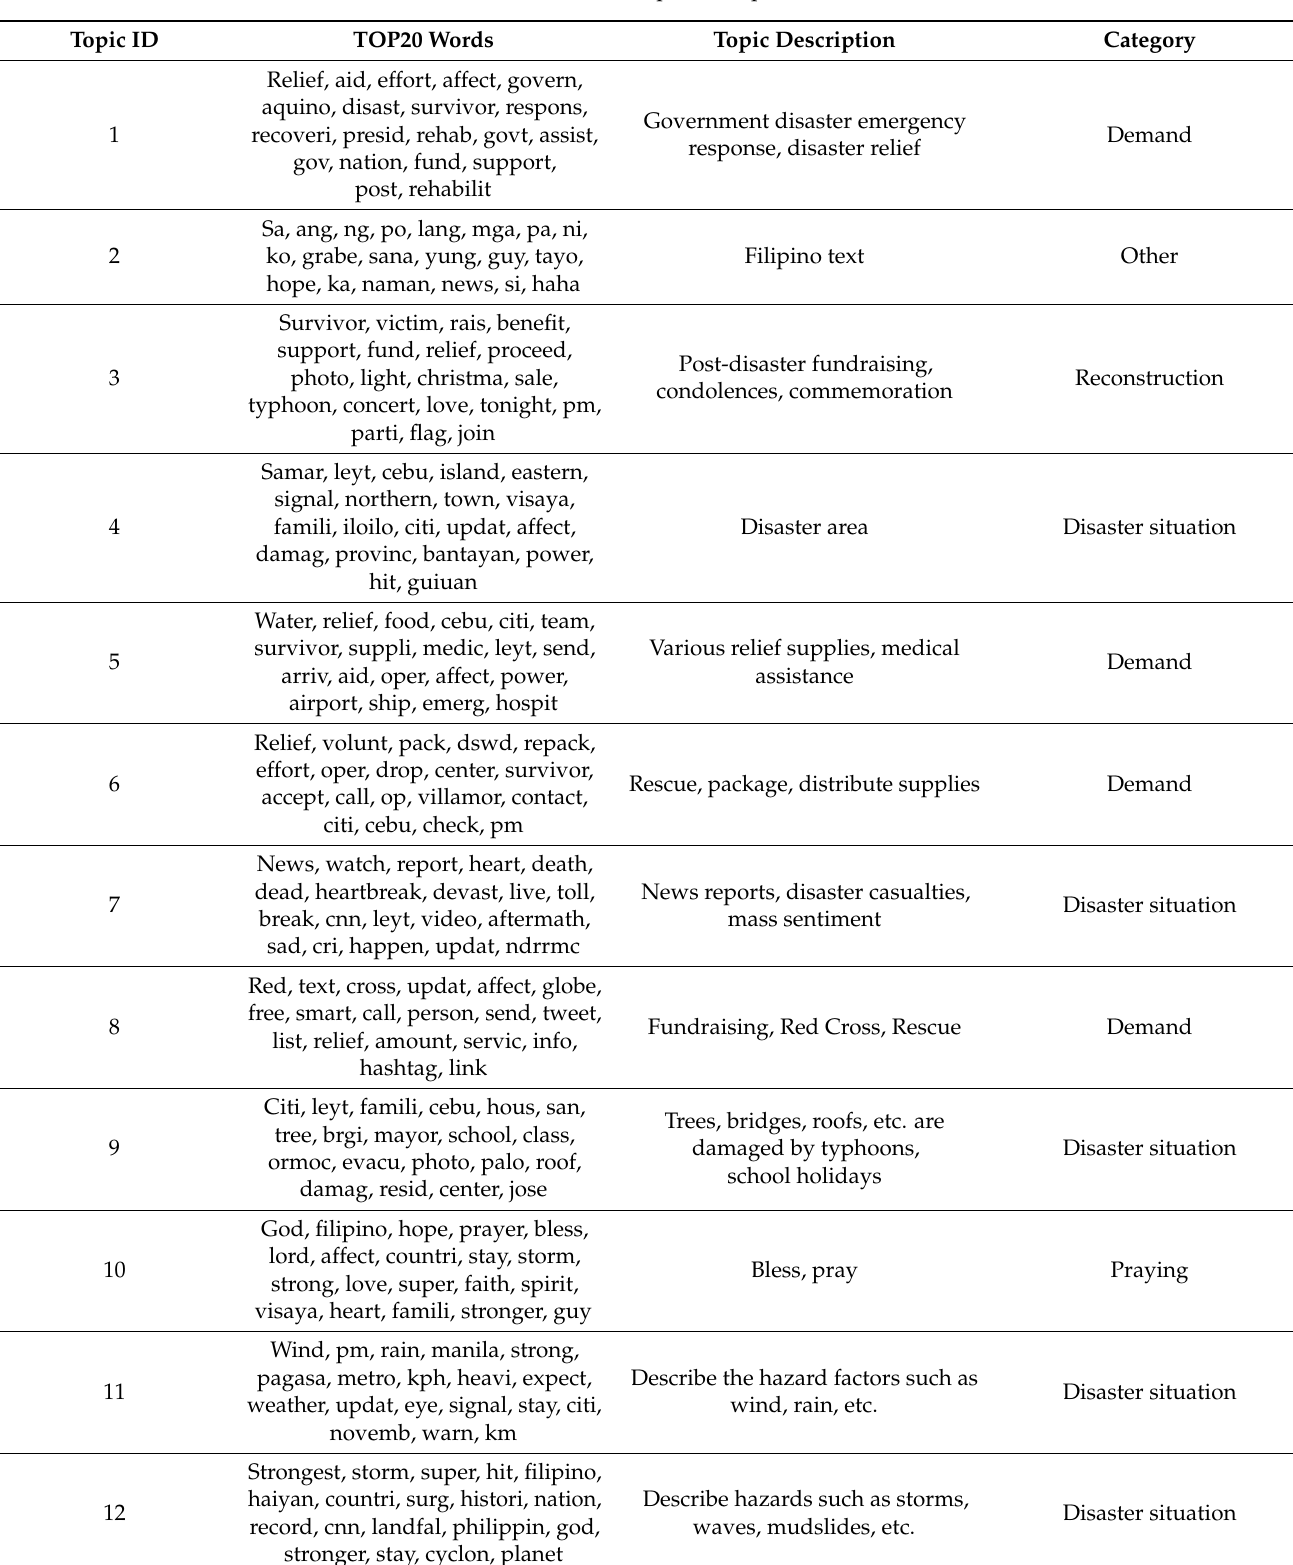
Table A2. Results of the manual topic description and